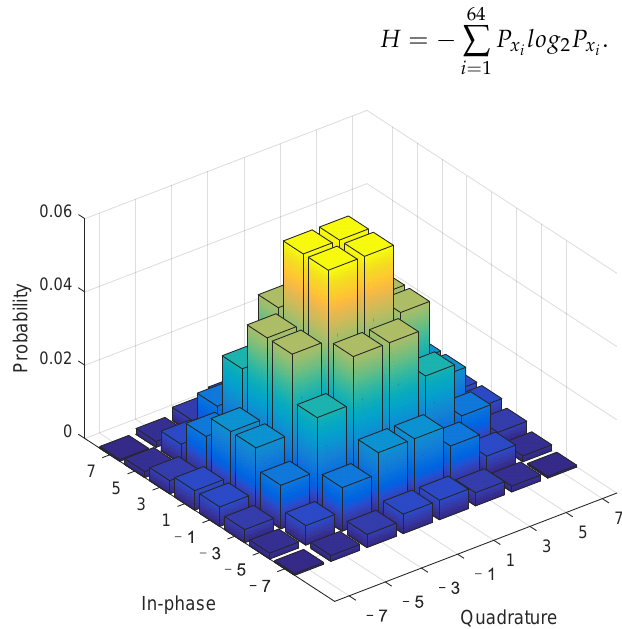
Figure 1. The probability distribution of